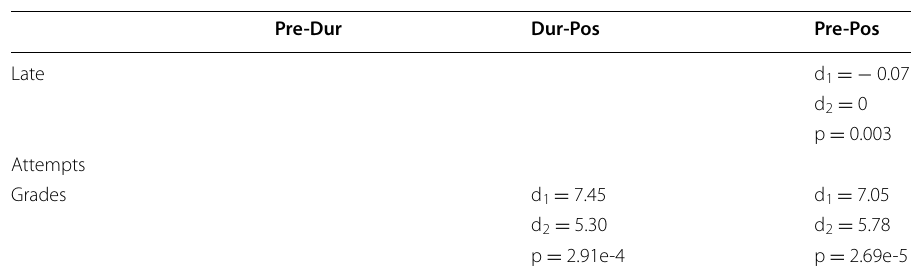
Table 8 By lockdowns: overall